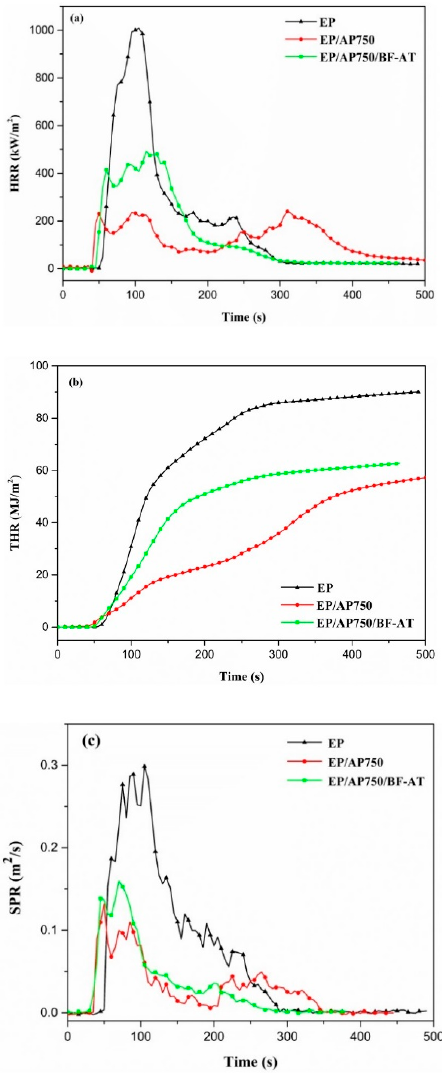
Figure 6. Cone calorimeter results of EP, EP/AP750 and EP/AP750/BF-AT in ( a ) heat release rate